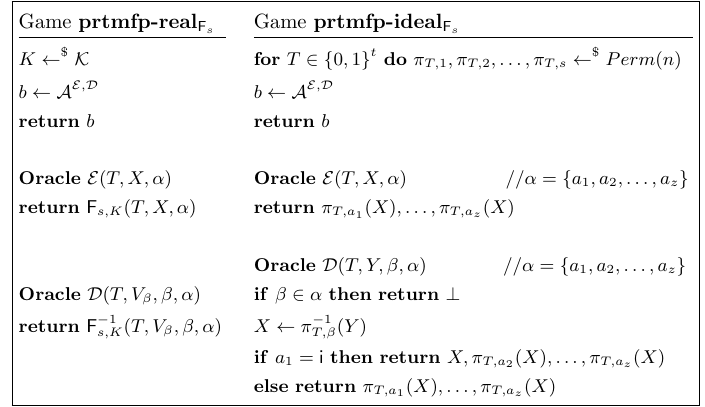
Figure 1: Games prtmfp-real F forkcipher F s